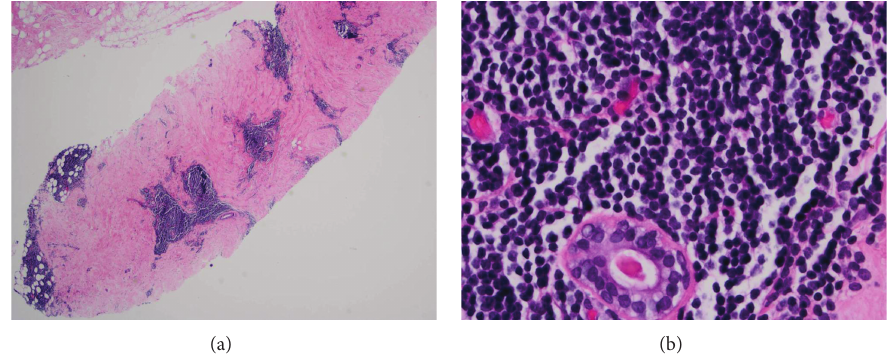
Figure 4: Chronic lymphocytic leukemia involving the breast. (a) Lymphocytic infiltrate is seen involving the stroma and adipose tissue (core biopsy, hematoxylin & eosin stain, 40x magnification). (b) Atypical small round monomorphic lymphocytes are present surrounding a benign duct (core biopsy, hematoxylin & eosin stain, 400x magnification).